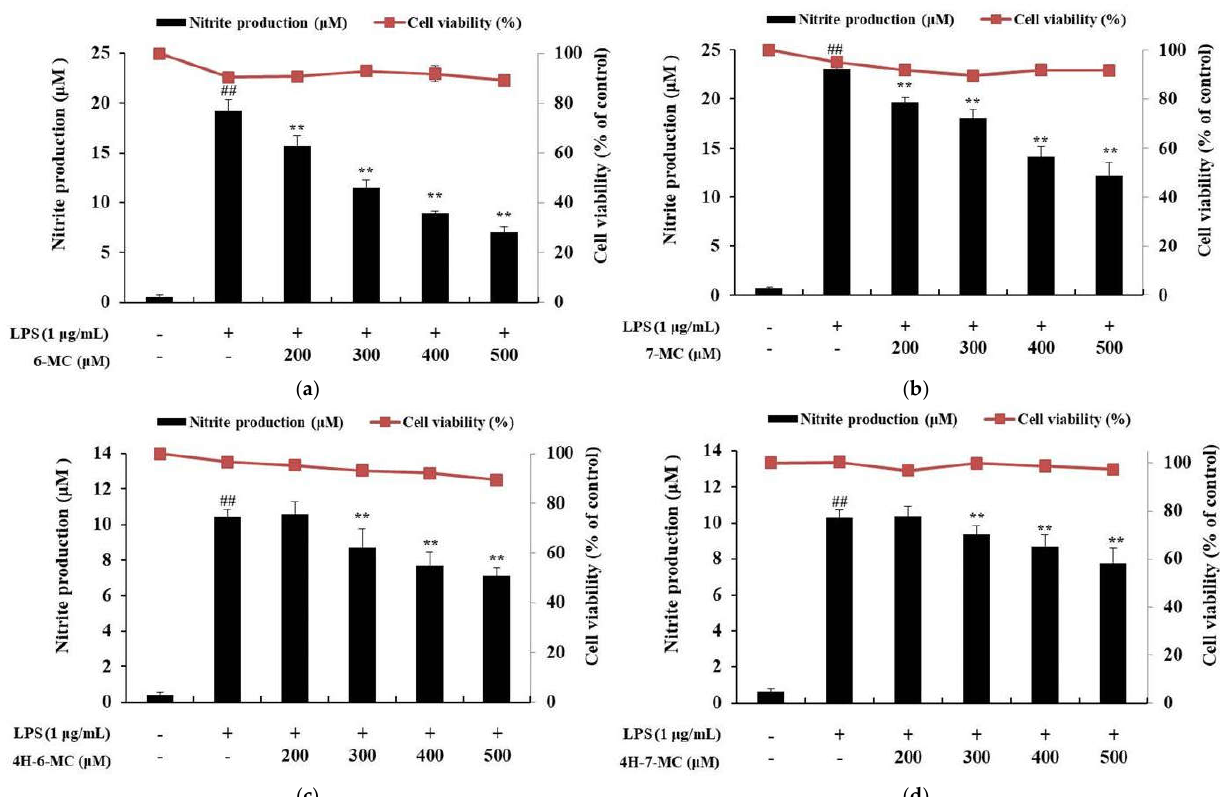
Figure 2. Effect of coumarin derivatives on nitric oxide production in LPS-stimulated RAW 264.7 cells. The cells were stimulated with 1 μg/mL of LPS only or with LPS plus various concentrations of coumarin derivatives for 24 h. Cell viability and NO production of LPS-induced RAW 264.7 cells subjected to ( a ) 6-methylcoumarin (6-MC), ( b ) 7-methylcoumarin (7-MC), ( c ) 4-hydroxy-6-methylcoumarin (4H-6-MC), and ( d ) 4-hydroxy-7-methylcoumarin (4H-7-MC) treatment was measured using MTT and Griess reagents, respectively. The results are presented as the mean ± SD from three independent experiments. ## p < 0.01 versus untreated control group. ** p < 0.01 versus LPS alone.